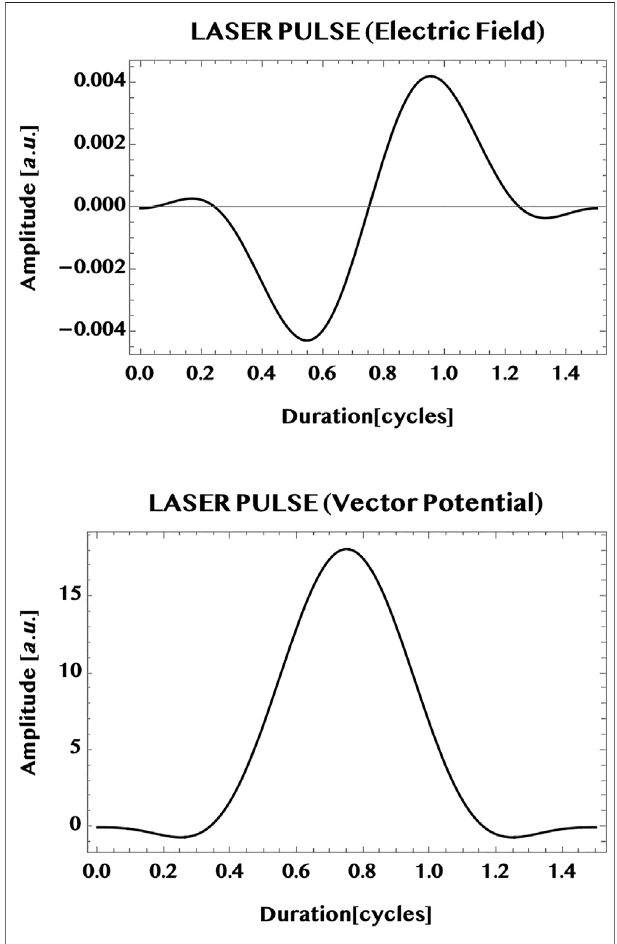
FIGURE 7 | Illustration of a typical ultrashort near-infrared laser pulse used for the simulations in this work (wavelength = 800 nm, peak intensity = 1 TW/cm 2 , CEP = 0, pulse duration = 1.5 cycles). Shown in the upper part is the “ sin 2 -envelope ” electric fi eldand inthelowerpart, thecorresponding vector potential. Vertical axis: pulse amplitude in a. u. ( fi eld strength [1 a. u.] = 514.22 V/nm), horizontal axis: pulse duration in cycles (1 cycle = T = 2 π / ω ): The pulse chosen is linearly polarised parallel to the armchair edge ( y -axis): ) cos ( ω t + CEP ) , where ^ e = unit polarisation F ( t ) (cid:1) ^ e y F y ( t ) (cid:1) ^ e y F 0 sin 2 ( π t t p vector, F 0 = peak fi eld strength, t p = pulse duration, ω = circular frequency, CEP = carrier-envelope-phase. The corresponding vector potential is A y ( t ) (cid:1) − c (cid:14) t F y ( t ′ ) dt ′ ,c=speedoflightinvacuum.Forthesimulationsinthis 0 work generally CEP = 0 is used (except for Figure 12 , where the CEP- dependence of the current in an armchair ribbon is